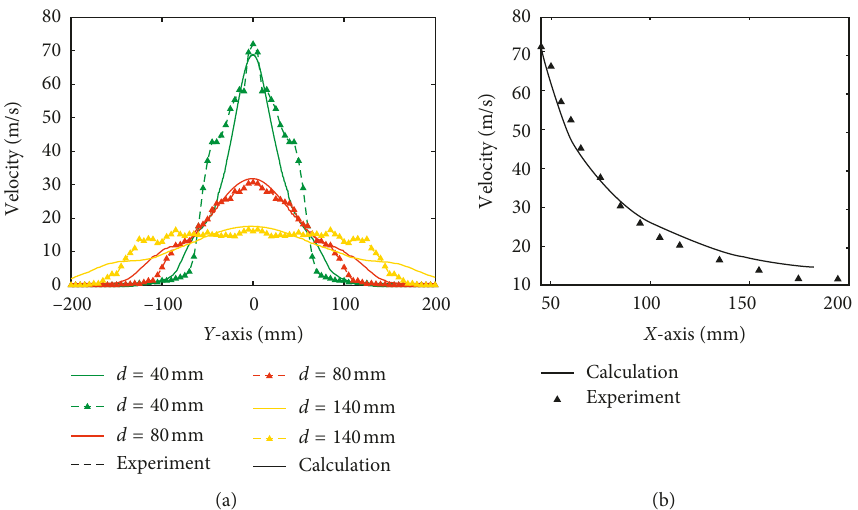
Figure 6: Comparison of computational and experimental gas velocity evolution. (a) Gas velocity along with the Y -axis for different measuring points; (b) gas velocity along with the X -axis.